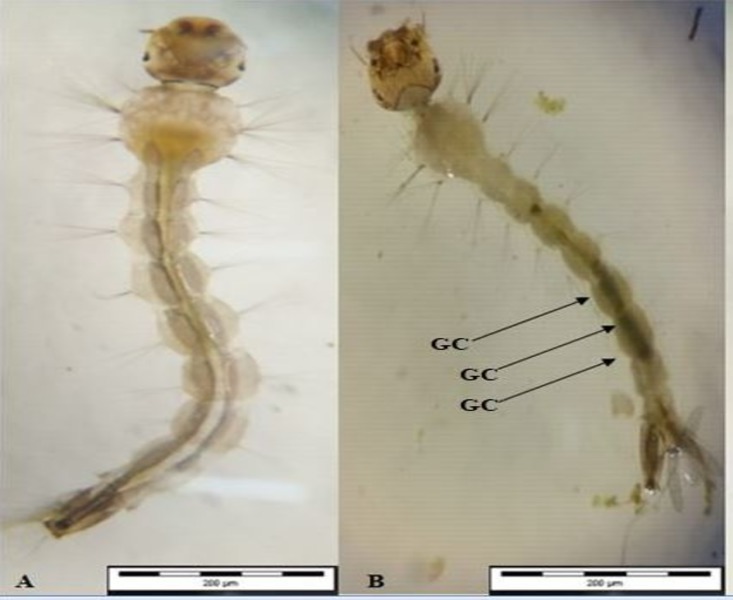
Morphological midgut content induced by Azolla pinnata plant extract from soxhlet extraction method in larvae of Ae. Aegypti.(A) Control test for midgut content view in early 4th instar larvae of Ae. Aegypti (B) A. pinnata crude extract for midgut content view in larvae of Ae. Aegypti Note: Arrows indicating the plant extracts (greenish colour), GC: gut content (after 24hours).